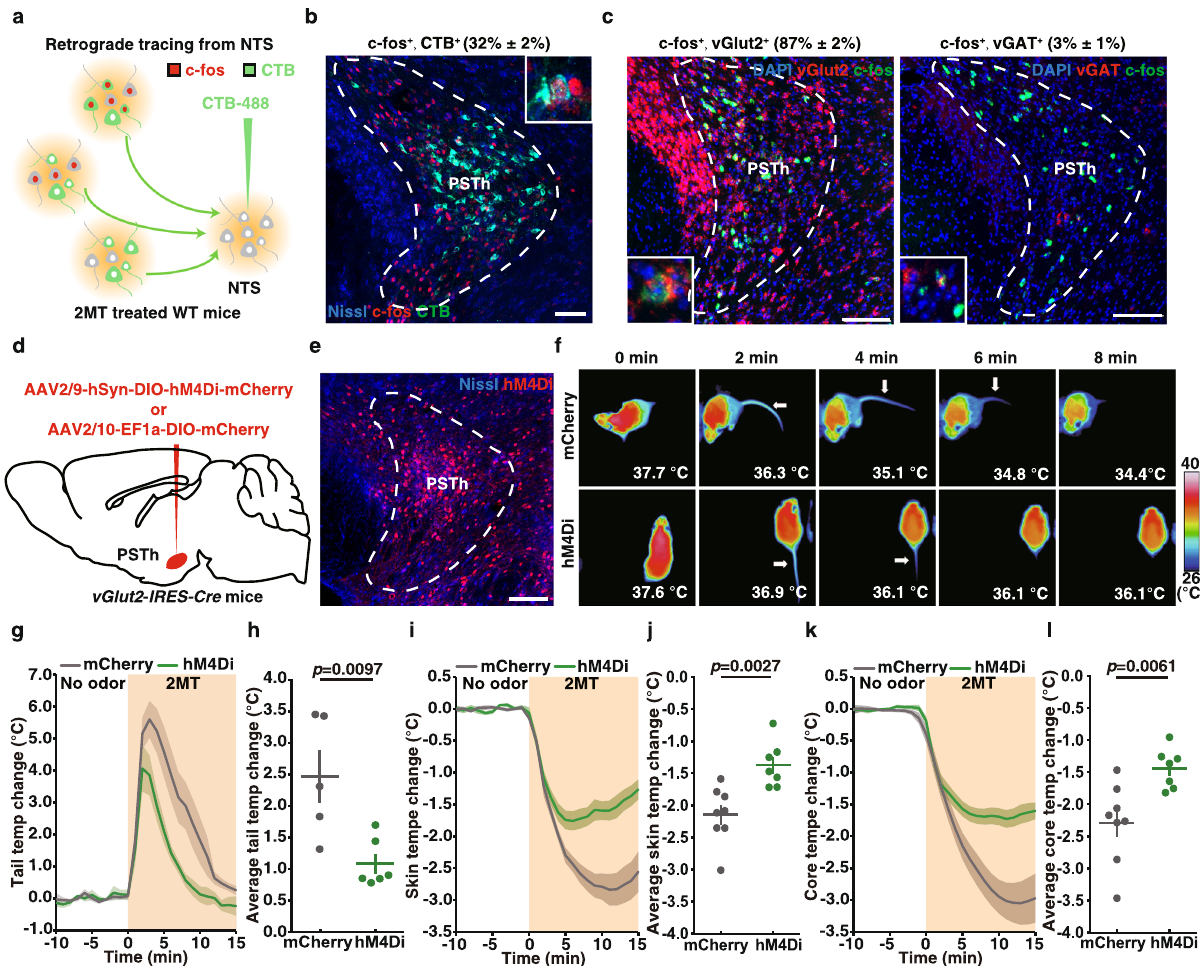
Fig. 2 Inhibition of vGlut2 + PSTh neurons attenuates 2MT-evoked hypothermia and tail temperature increase. a Schematic of retrograde tracing from NTS neurons by CTB injection. b Representative image showing double immunostaining of CTB and c-fos. The percentage of double-positive neurons (CTB + , c-fos + /CTB + %) in PSTh is in parenthesis ( n = 3). c Representative images and quantitative analysis showing the percentage of c-fos + , vGlut2 + or c-fos + , vGAT + double-positive neurons among c-fos + neurons in PSTh by two-color in situ hybridization ( n = 3). d Schematic of chemogenetic inhibition experiment of vGlut2 + PSTh neurons in vGlut2-IRES-Cre mice. e Representative image of hMD4i-labeled vGlut2 + PSTh neurons ( n = 7). f Time-lapsed thermal images of mCherry-expressing mice and hM4Di-expressing mice during 2MT treatment following administration of C21. Tail ( g ), skin ( i ), and core ( k ) temperature curves of mice with (hM4Di, n = 7) or without (mCherry, n = 8) inactivation of vGlut2 + PSTh neurons before and during 2MT treatment. Average tail ( h ), skin ( j ), and core ( l ) temperature changes of mice with (hM4Di, n = 7) or without (mCherry, n = 8) inactivation of vGlut2 + PSTh neurons during 2MT treatment. A few mice were not included in the analysis of tail temperature ( e ) because their tails were frequently obscured in the thermal images. g – l Data are mean ± SEM; two-side Student ’ s t test. Scale bars, 100 µ